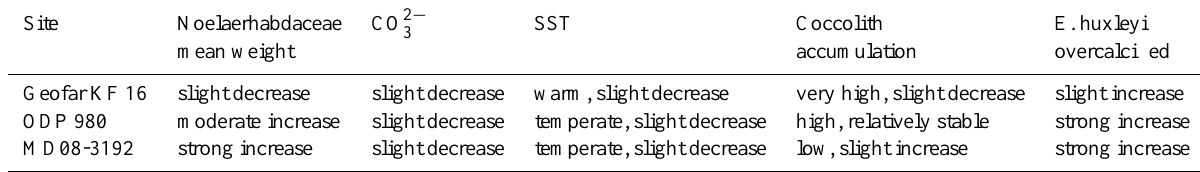
Table 1. Summary of Noelaerhabdaceae weight trends and controlling